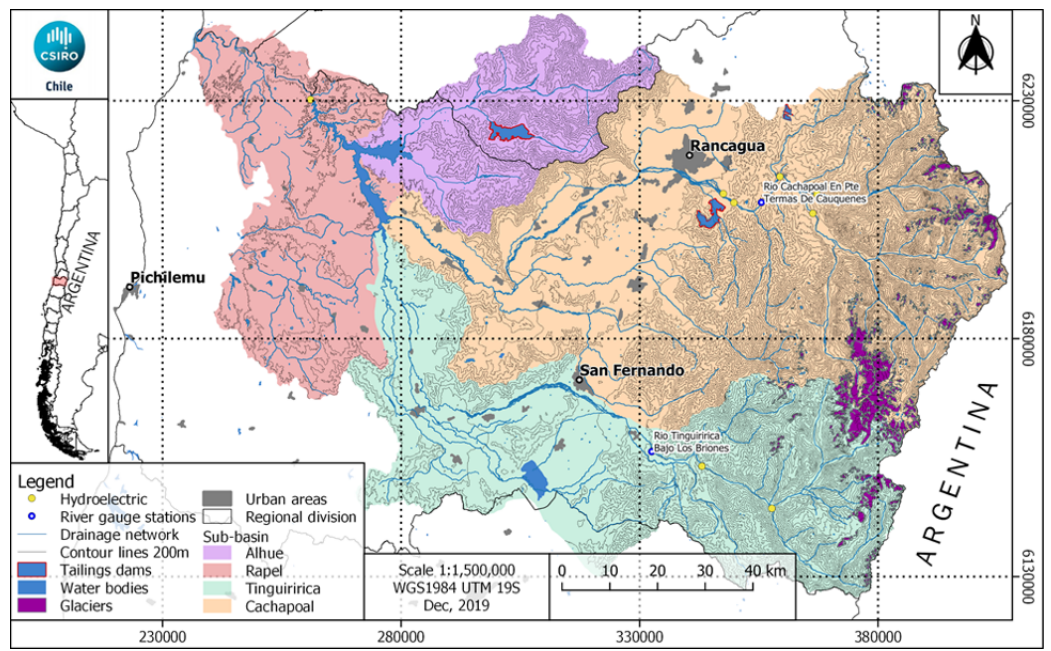
Figure 1. Location of the RRB and its main sub-basins and spatial